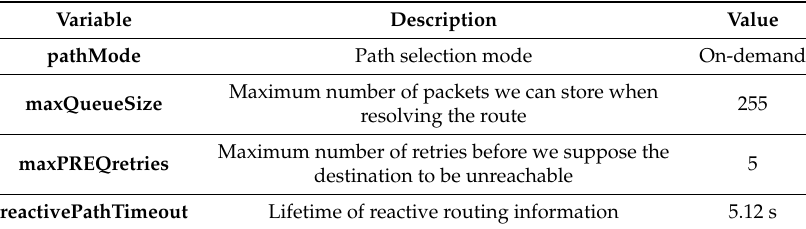
Table 6. Hybrid Wireless Mesh Protocol (HWMP)